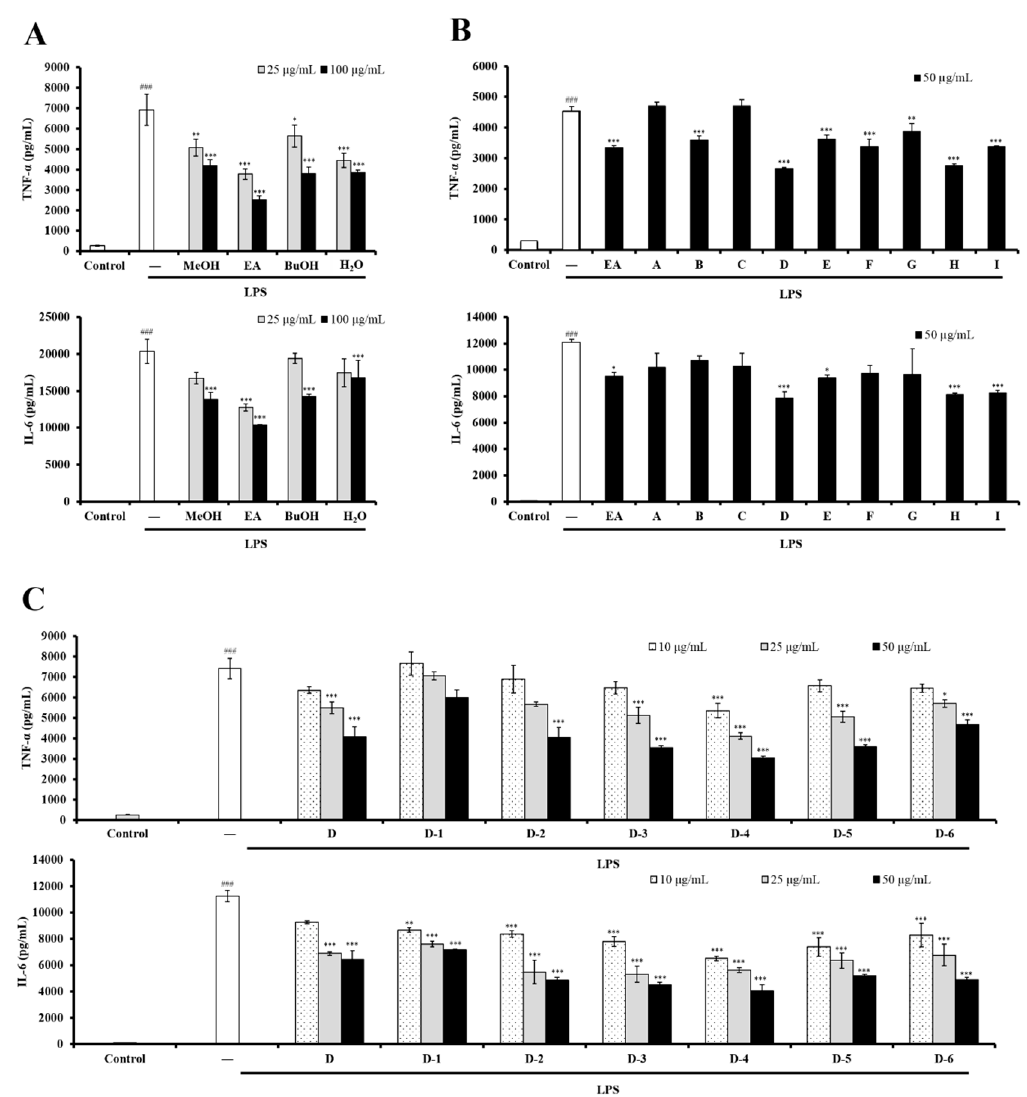
Figure 1. The e ff ects of UC methanolic extract and of its EtOAc-, n -BuOH-, H 2 O-soluble fractions and subfractions of the EtOAc-soluble fraction on pro-inflammatory cytokine production in LPS-stimulated dendritic cells (DCs). DCs were untreated or treated with LPS (100 ng / mL, white bar). ( A ) Methanolic extract and EtOAc, n -BuOH, and H 2 O subfractions (25 µ g / mL, gray bar, or 100 µ g / mL, black bar) were used. ( B ) EtOAc and Fr. A to I subfractions (50 µ g / mL, black bar) were used. ( C ) Fr. D and D-1 to D-6 subfractions (10 µ g / mL, hatch bar, 25 µ g / mL, gray bar, or 50 µ g / mL, black bar) were used. Supernatants were collected 6 h after the treatment. The production of cytokines (TNF- α and IL-6) was measured by ELISA. The data shown are the mean ± SD of three independent experiments; ### p < 0.001; * p < 0.05; ** p < 0.01; *** p < 0.001 (Sche ff e’s test) for comparisons of the treated and untreated LPS-stimulated DC samples.